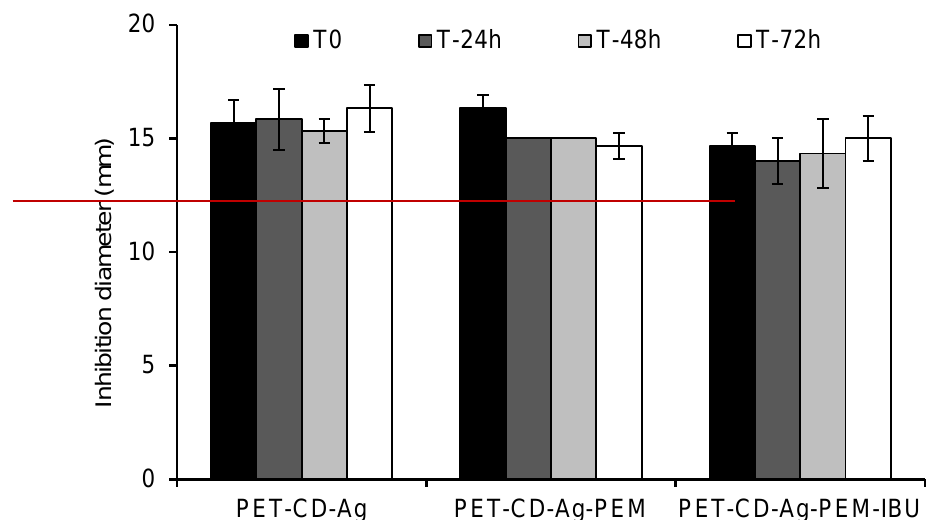
Figure 9. Inhibition diameter in the Kirby–Bauer test against E. coli of dressing samples at 0, 24, 48 and 72 h of immersion in PBS pH 7.4 media (80 rpm, 37 °C). The red line in the graph indicates the diameter of dressing samples (11 mm) placed onto Muller-Hinton agar.